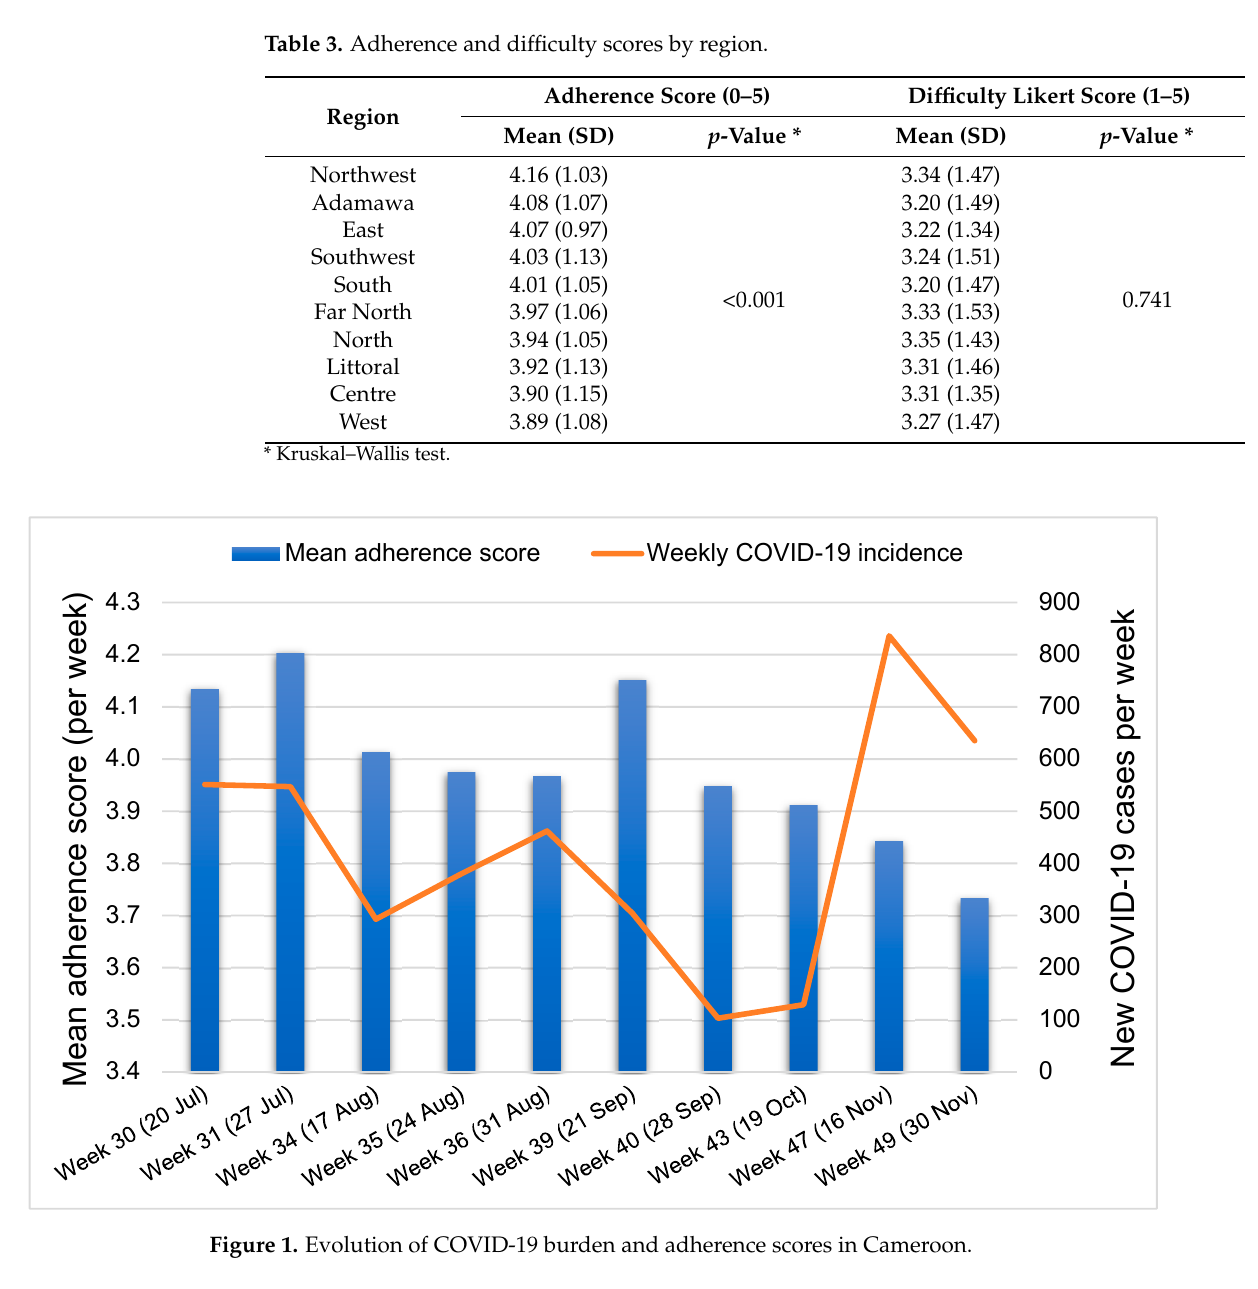
Table 3. Adherence and difficulty scores by region.